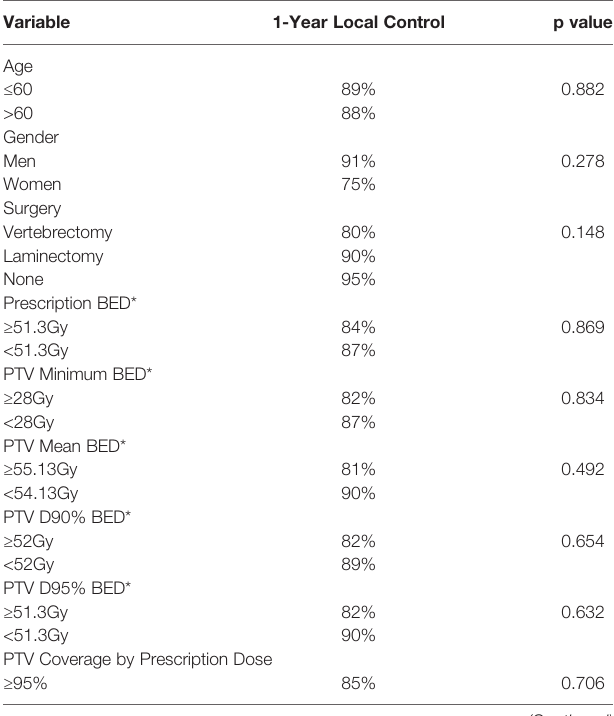
TABLE 2 | Univariate analysis examining for variables associated with improved local control in patients with ≥ 3 contiguous treated levels using a proportional hazards